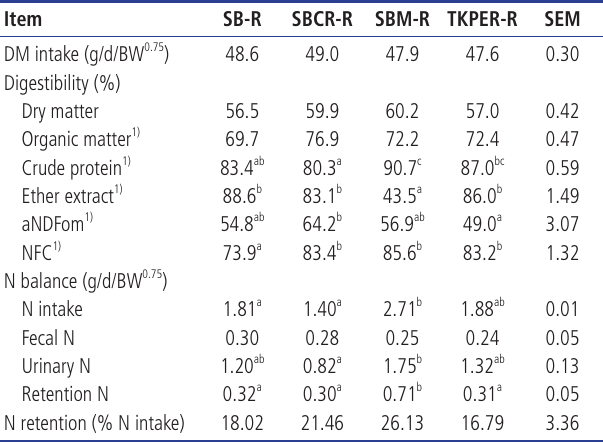
Table 3. DM intake, apparent digestibility and nitrogen balance of the experimental diets in wethers Item